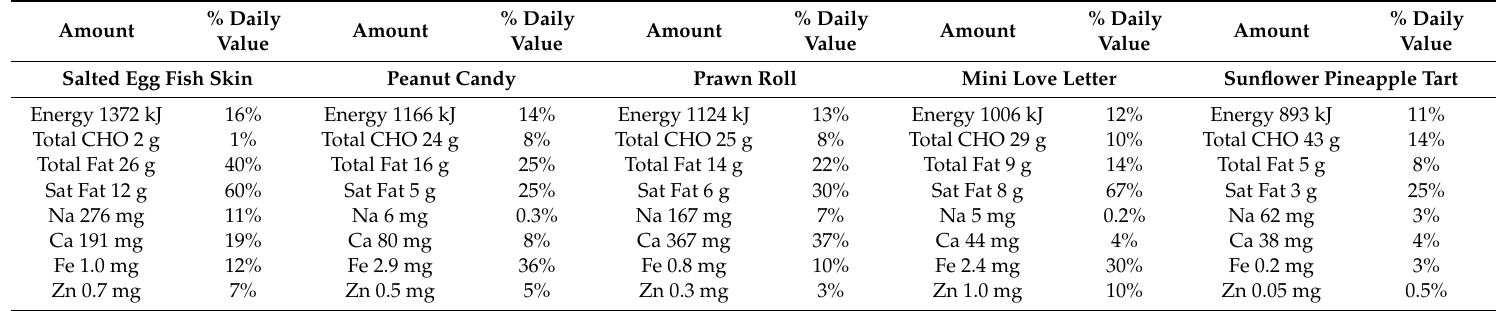
Table 4. Nutrient contents of 50 g selected snacks. Percent Daily Value based on an 8368 kJ (2000 kCal)